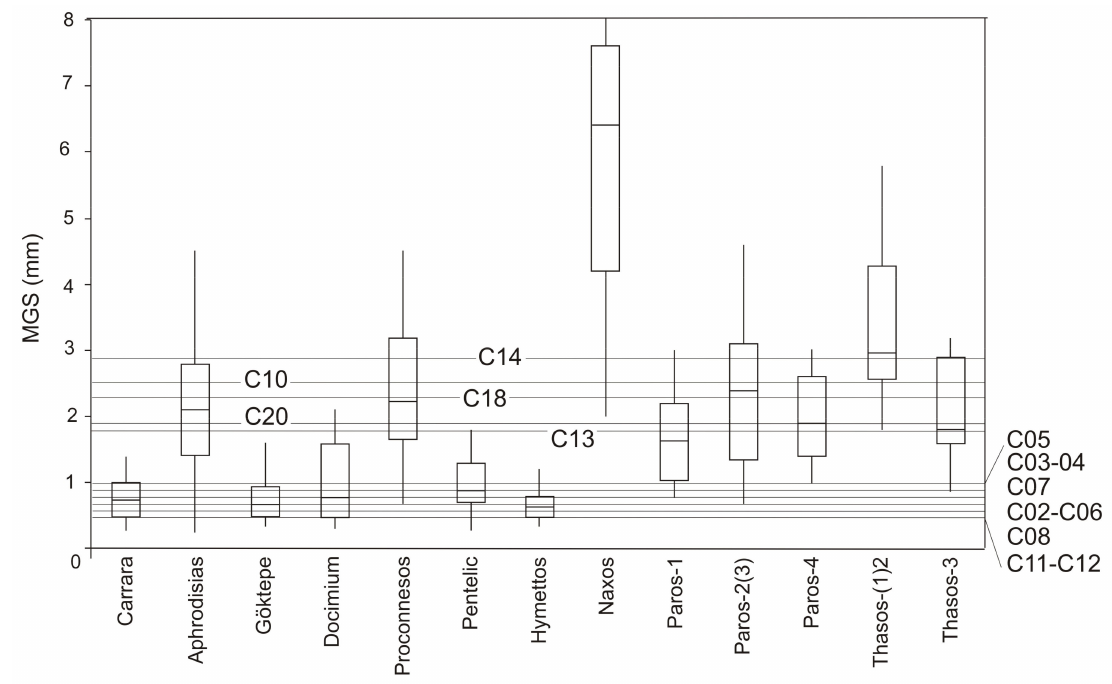
Figure 4. Maximum grain size (MGS) values of the analyzed marble samples compared with those of the Mediterranean area used in antiquity